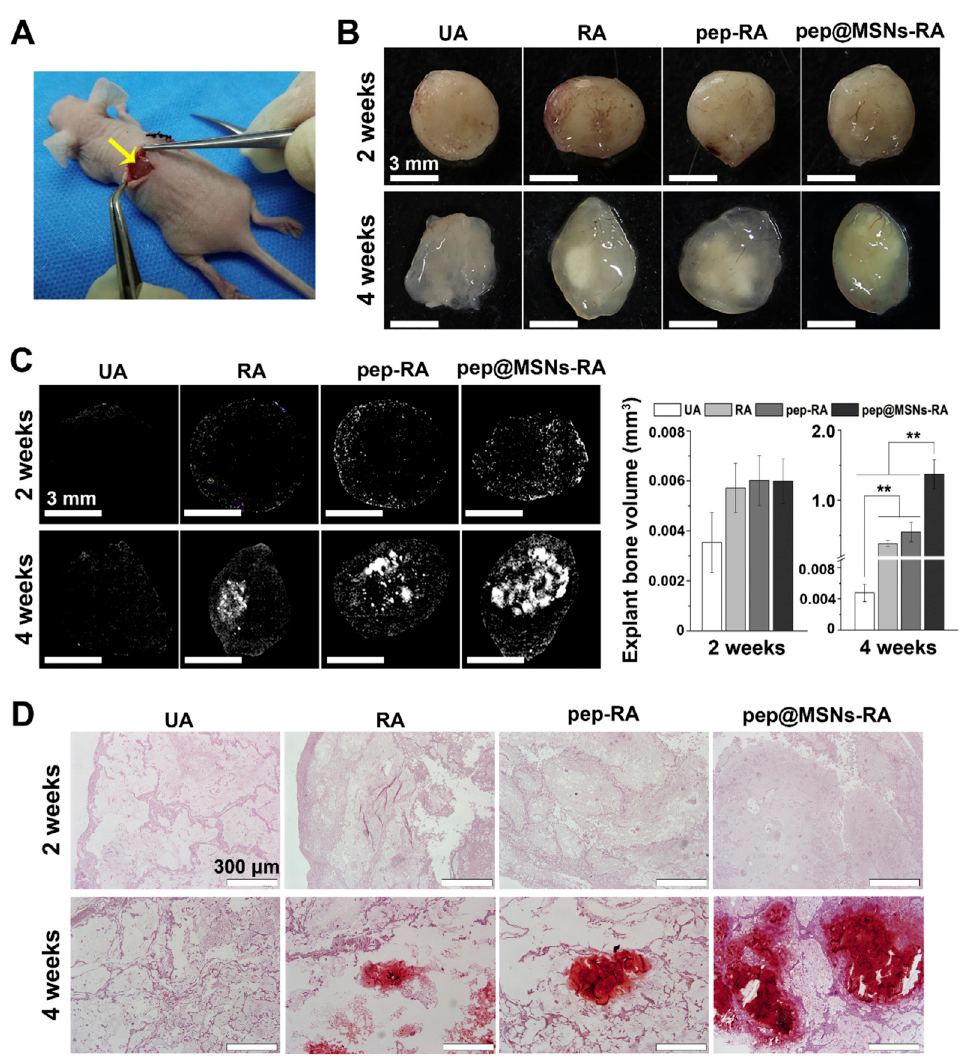
Figure 10. Visualized gross view and quantified volume of mineralized matrix in different human mesenchymal stem cell (hMSC)-loaded gels in vivo. ( A ) Gels encapsulated with hMSCs were subcutaneously implanted into nude mice. ( B ) Gross view of different hMSC-loaded gels following removal from mice 2 and 4 weeks post-surgery. ( C ) Micro-CT reconstruction images of gel mineralization and quantitative bone volume analysis after 2 and 4 weeks of implantation. ( D ) Alizarin Red-S (ARS) staining of the implanted hMSC-loaded gels after 2 and 4 weeks of subcutaneous implantation. The p values were calculated by Tukey’s post hoc test (** p < 0.01). All data represent mean ± SD (n = 3) [135].